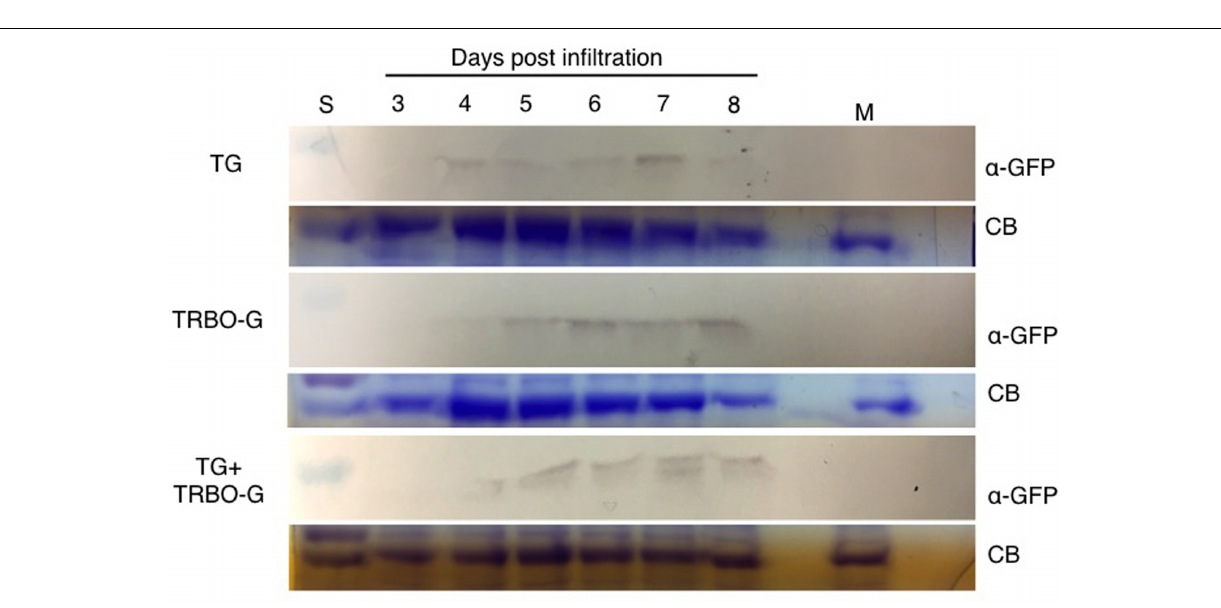
FIGURE 5 | Time-course for GFP detection in tomato infected with vectors as indicated. Samples were taken from 3 to 8 dpi. Mock (M) was taken at 8 dpi. The red colored size marker (S) on the left of western blots is 25 kDa, while the size of the intense CB band of a host protein is about 55 kDa as inferred from the size marker on the